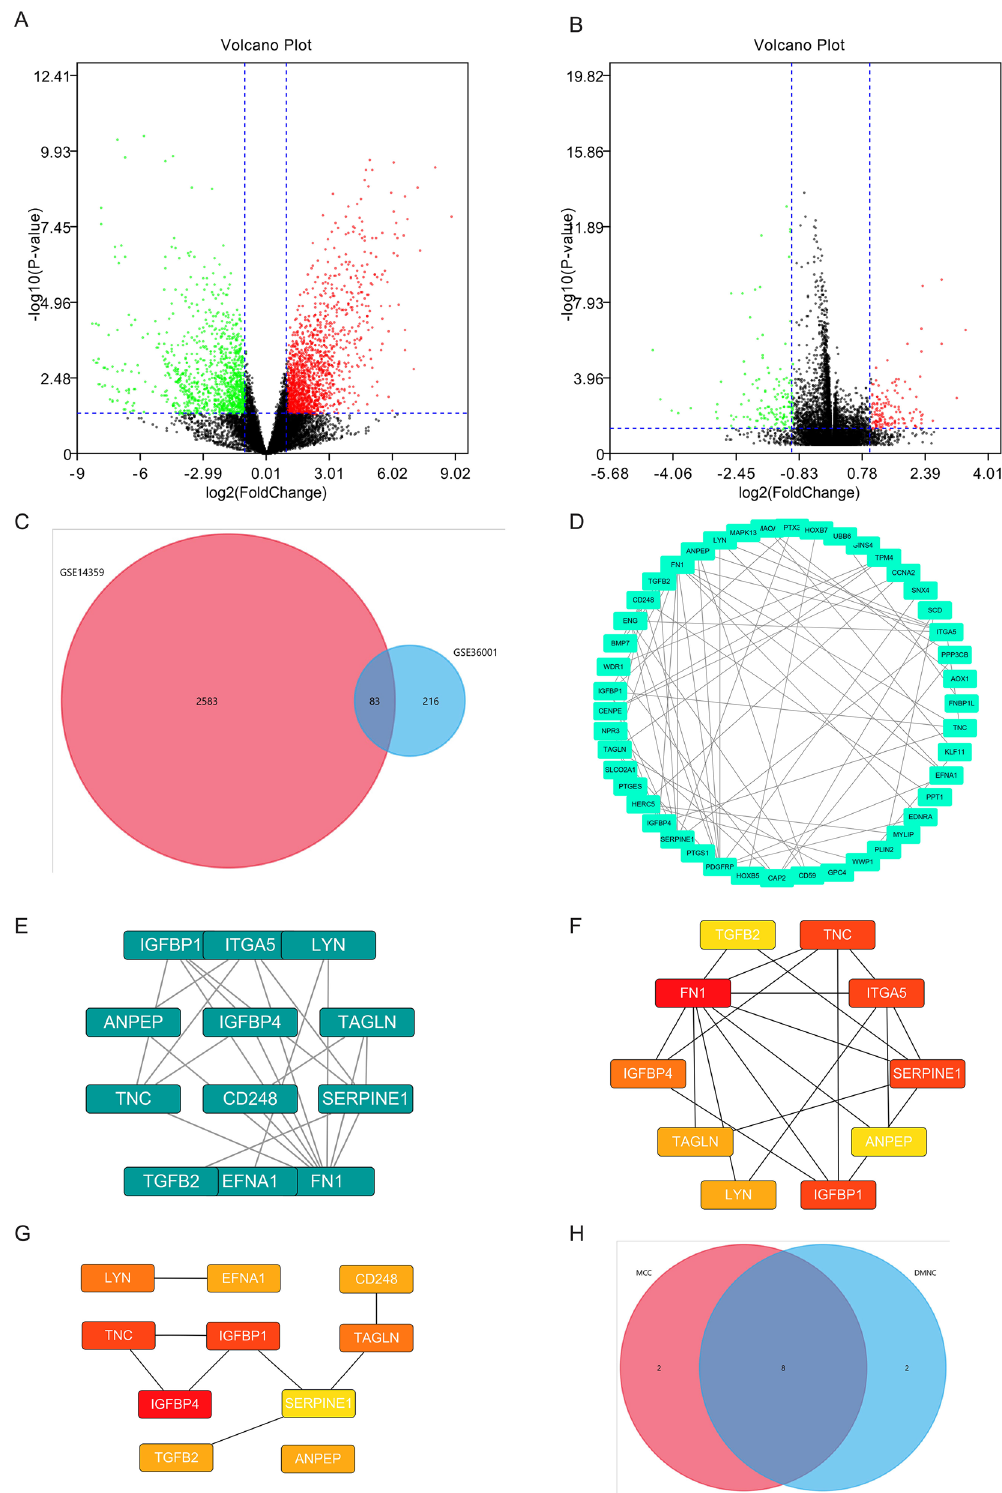
Figure 1. Two the DEGs. ( A ) The volcano plots present DEGs in the GSE14359. ( B ) The volcano plots present DEGs in the GSE36001. ( C ) The common DEGs between GSE14359 and GSE36001. ( D ) PPI network. ( E ) The key module of MCODE analysis. ( F ) The top 10 genes screened by cytoHubb in MCC. ( G ) The top 10 genes screened by cytoHubb in DMNC. ( H ) Venn diagram figured out eight mutual genes between the algorithms, including IGFBP4, TAGLN, LYN, TNC, TGFB2, IGFBP1, SERPINE1,